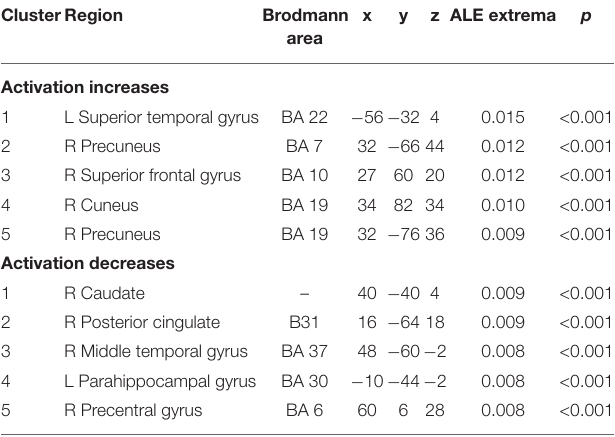
TABLE 4 | ALE clusters derived from inhibitory control task in overall